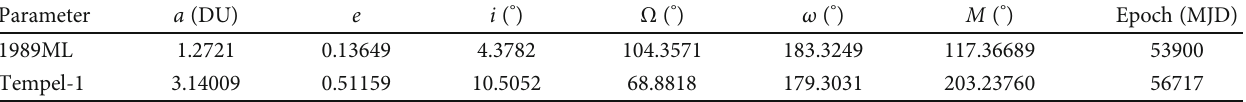
Table 1: Classical orbital elements of 1989ML and Temple-1 at the given epoch MJD.